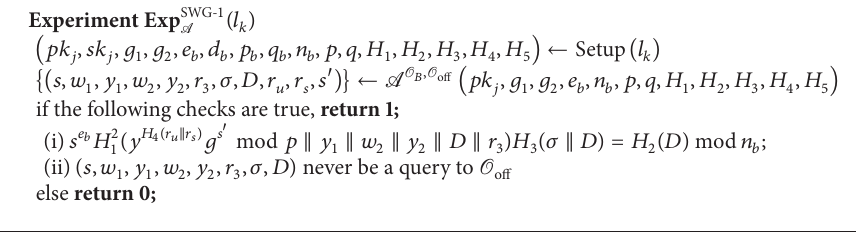
Algorithm 6: Experiment SWG-1.